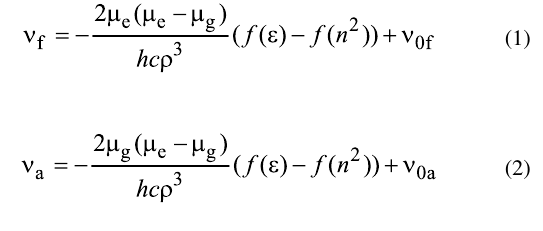
The data points for the dipolar aprotic solvents acetonitrile, ace- tone and ethyl acetate and the nonpolar n -hexane, shown by filled circles in Figure 3a, lie along a straight line. From its slope of − 7210 cm − 1 and μ g = 11.97 D the value of μ e = 18.30 D is calculated. The fluorescence spectra of NR in the protic solvents ethanol and methanol are substantially shifted to the red (Figure 2a), although they possess similar f ( ε ) − f ( n 2 )